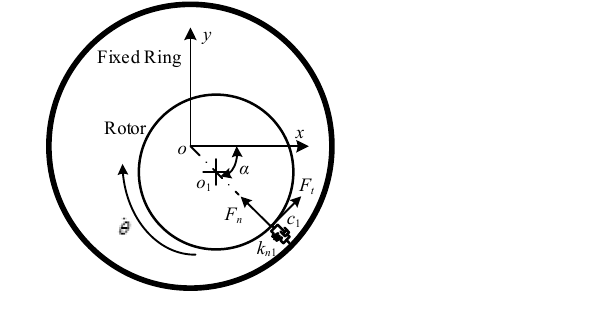
Figure 5. Mechanical model of the “rotor-fixed ring” protection device.